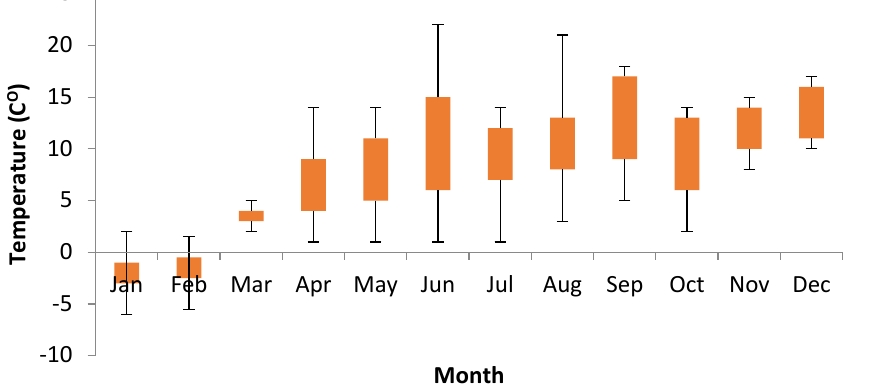
Figure 3. Monthly temperature for the basin. Appl. Sci. 2019 , 9 , x FOR PEER REVIEW Figure 3 . Monthly temperature for the basin. Figure 3 . Monthly temperature for the basin.